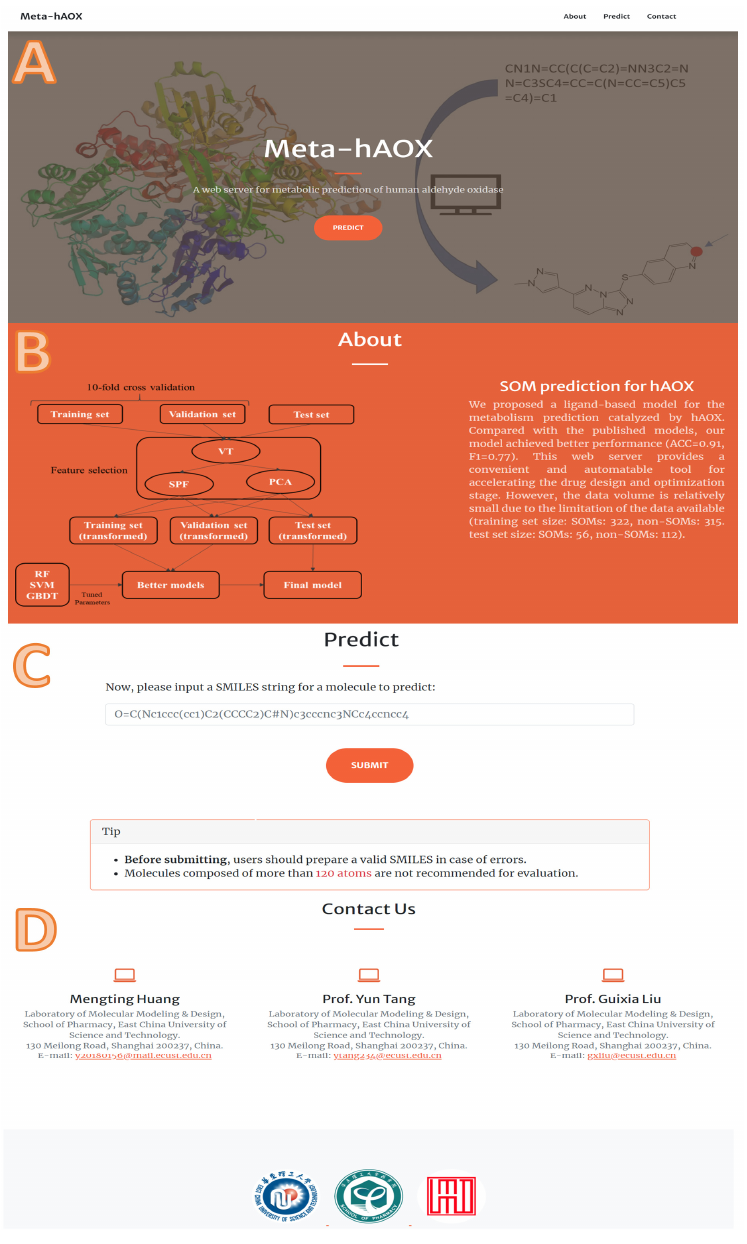
Figure 6. The details of our web server: ( A ) home, ( B ) about, ( C ) prediction, ( D ) contact. We also compared our model with published models, including the DT AOX model [13], DTN AOX [12], and three descriptors proposed by Montefiori et al. [11]; the